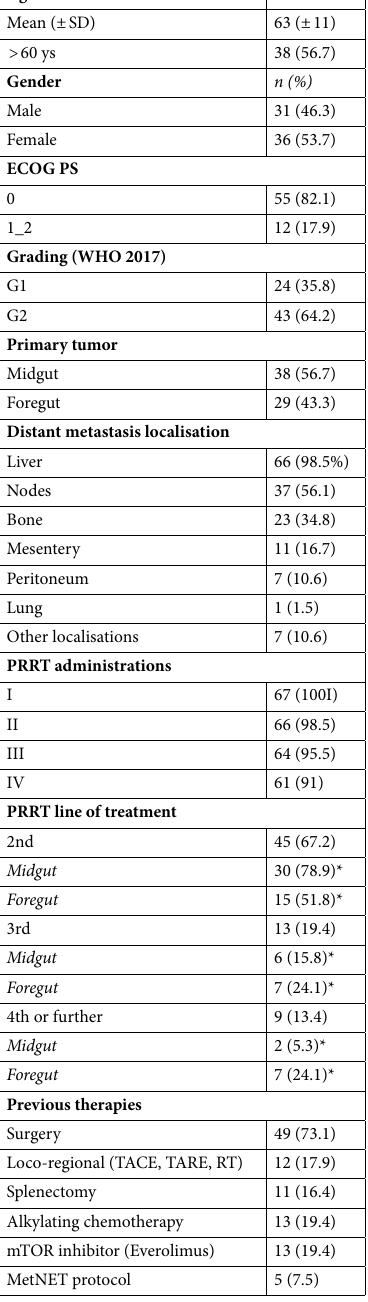
Table 1. Selected study population. TACE, transarterial chemoembolisation; TARE, transarterial radioembolisation. *percentage calculated considering midgut and foregut